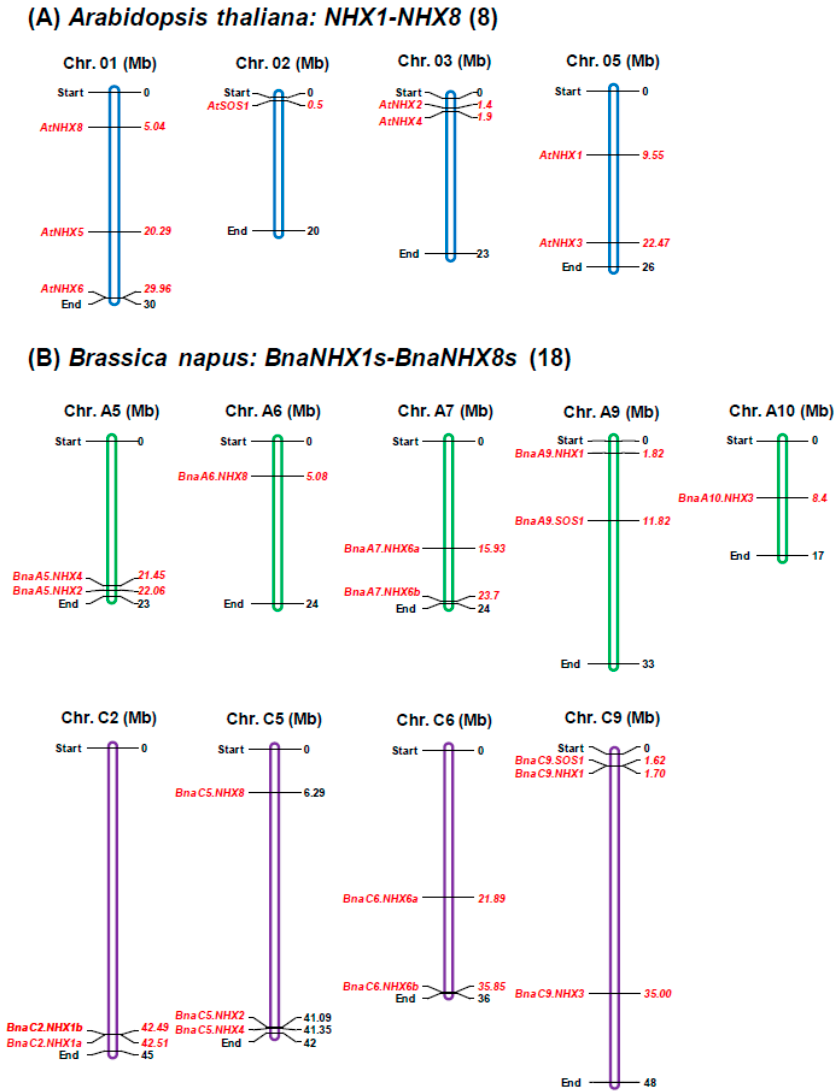
Figure 2. Physical mapping of the Na + /H + antiporter ( NHX ) family members in Arabidopsis thaliana and Brassica napus . ( A - B ) Genomic distribution of the Arabidopsis NHXs ( A ) and their homologs in B. napus ( B ).